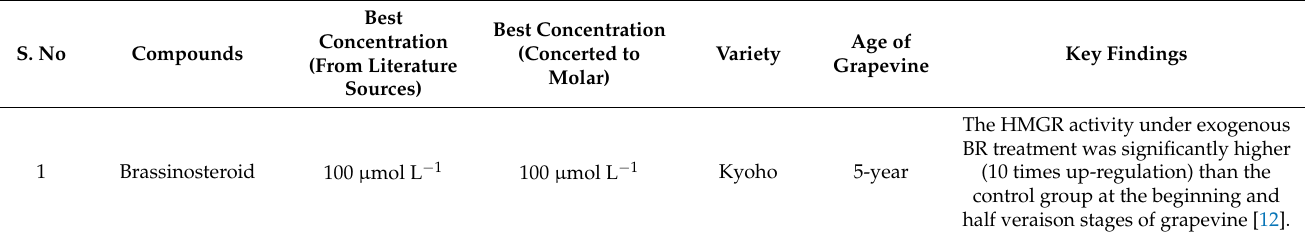
Table 5. Effect of exogenous brassinosteroid/brassinolide on fruit quality at enzymatic activ- ity